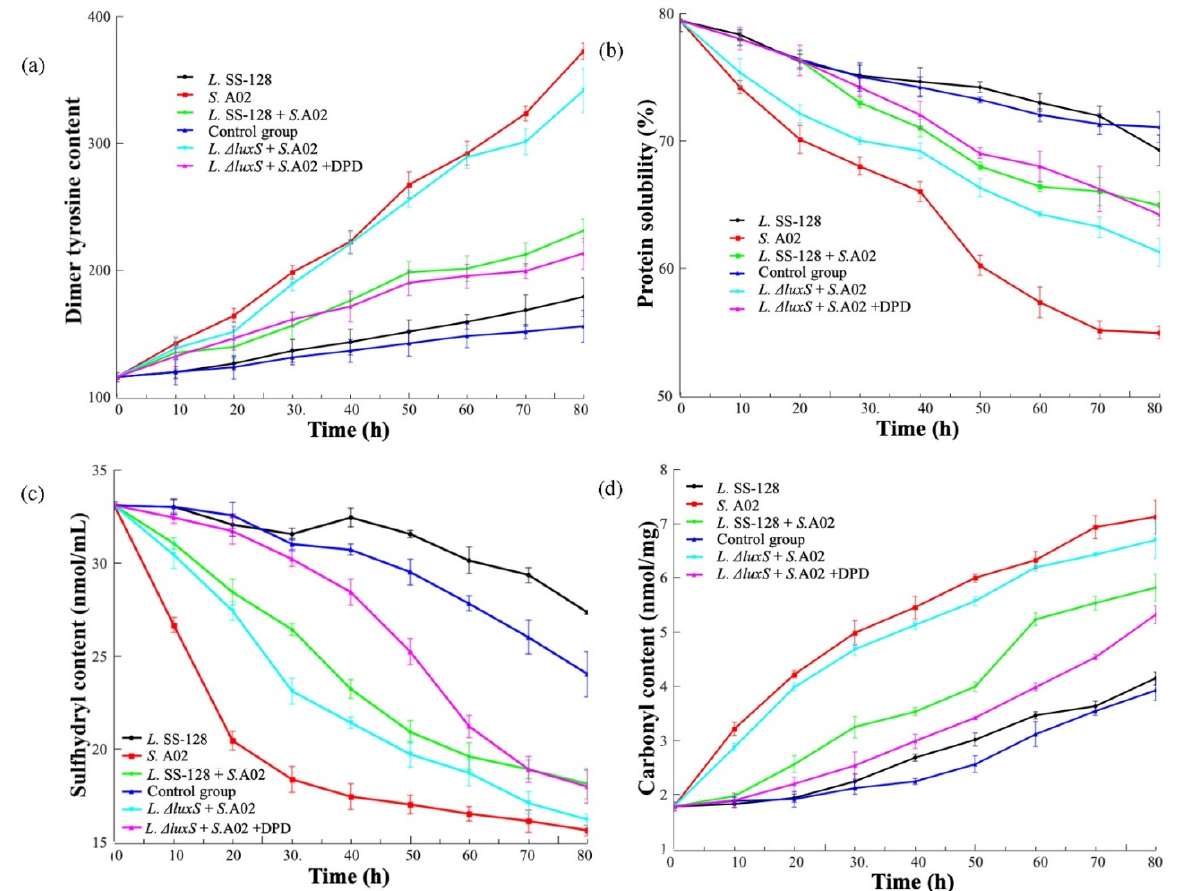
Figure 4. Protein changes in the myofibril simulation system. ( a ) Dimer tyrosine content; ( b ) Protein solubility; ( c ) Sulfhydryl content; ( d ) Carbonyl content.